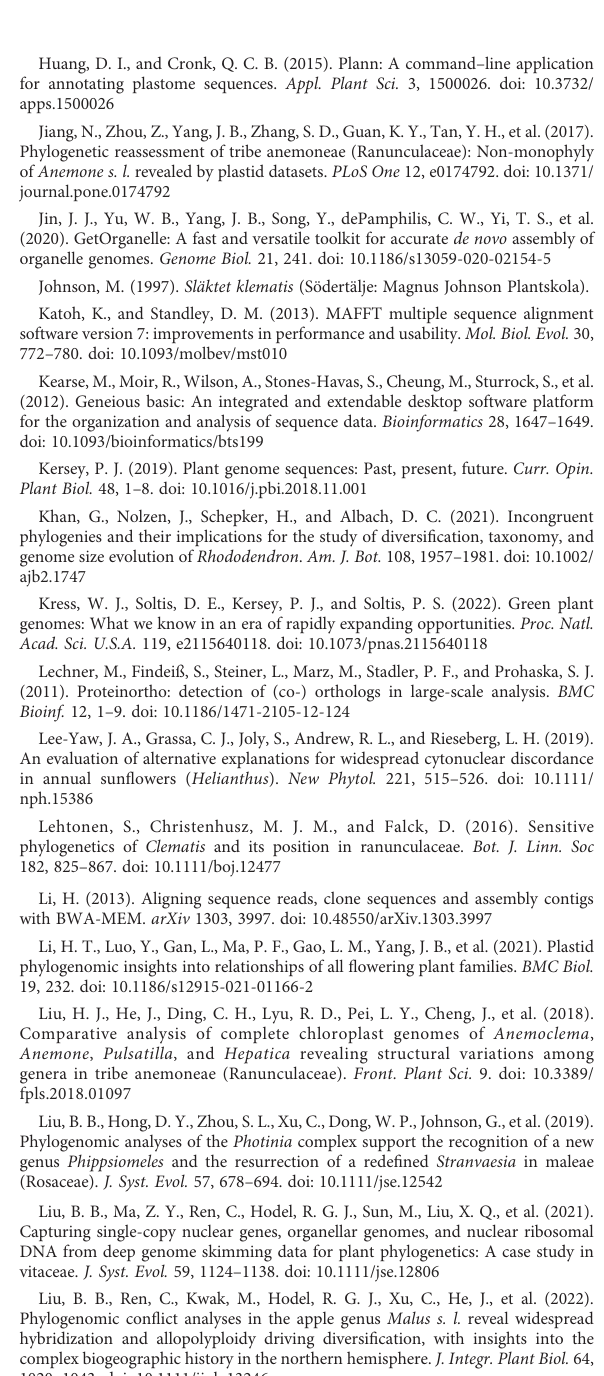
SUPPLEMENTARY FIGURE 4 Maximum likelihood phylogenetic trees constructed from two nuclear SNPs data matrices obtained by Geneious